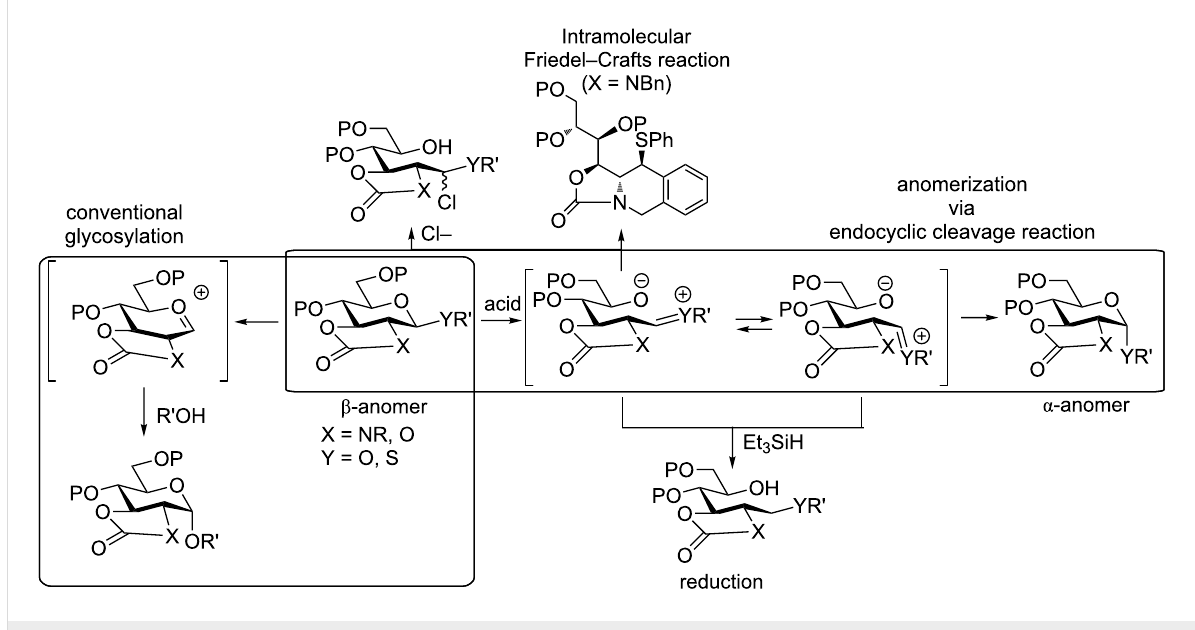
Scheme 2: Anomerization via endocyclic cleavage.